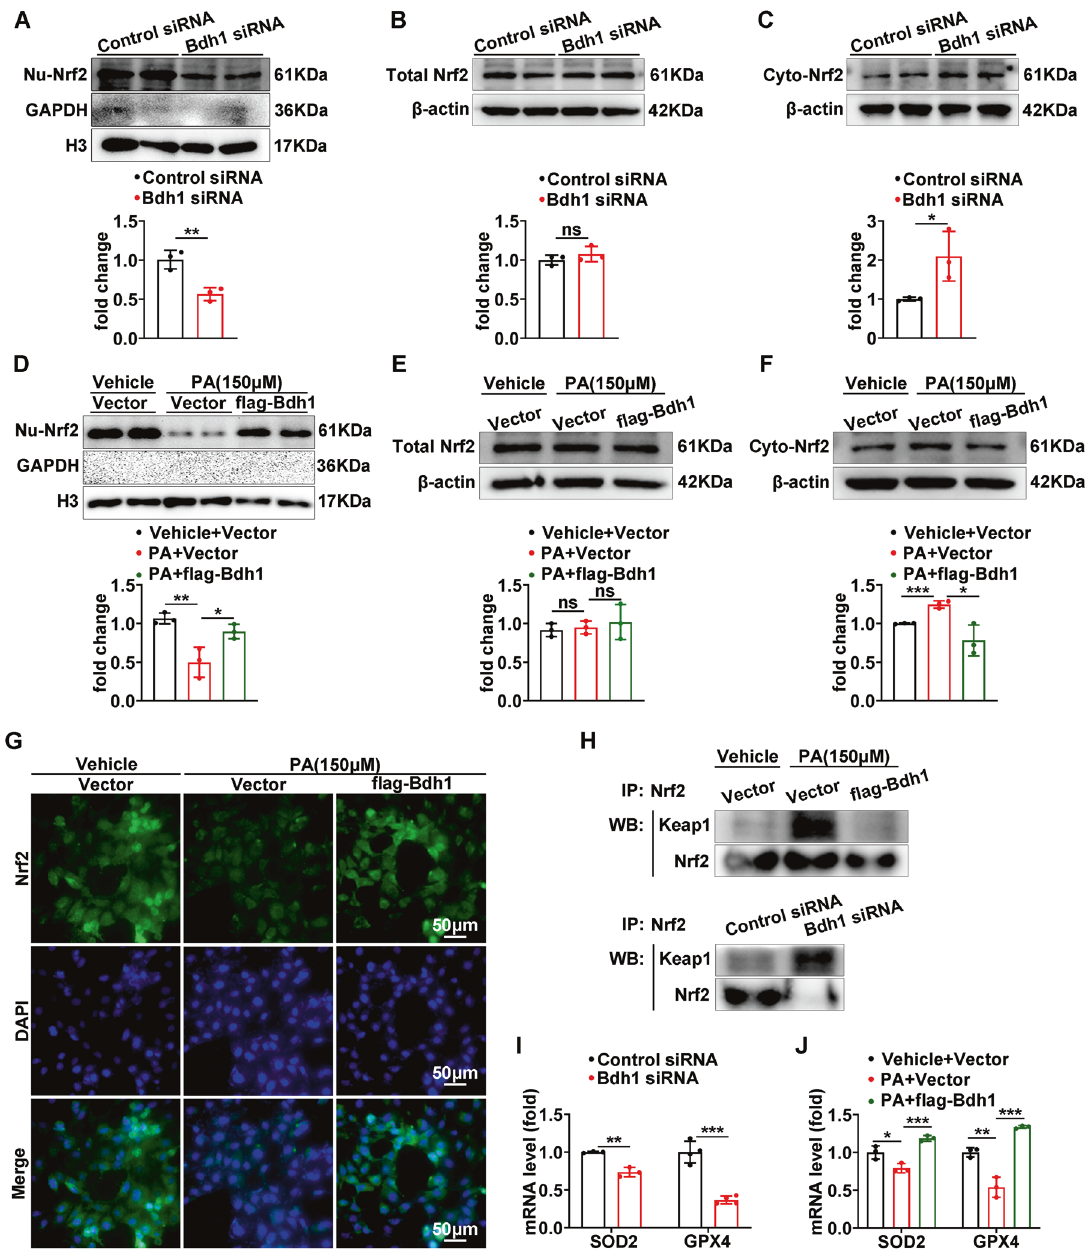
Fig. 4 Bdh1 promotes Nrf2 nuclear translocation and Nrf2-mediated antioxidant pathway. A – C Representative western blots showing the protein level of Nrf2 protein in the nuclear extracts ( A ), cytosolic extracts ( B ), and total lysates ( C ) of LO2 cells transfected with control siRNA or Bdh1 siRNA. D – F Representative western blots showing the protein level of Nrf2 in the nuclear extracts ( D ), cytosolic extracts ( E ), and total lysates ( F ) of vetor and Bdh1-overexpressed LO2 cells treated by vehicle or PA. G Representative IF images showing the location of Nrf2 in vetor and Bdh1-overexpressed LO2 cells treated by PA. Bar: 50 μ m. H Immunocoprecipitation showing the interaction between Keap1 and Nrf2 in LO2 cells with indicated treatment. I mRNA levels of GPX4 and SOD2 in LO2 cells transfected with control or Bdh1 siRNA. J mRNA levels of GPX4 and SOD2 in LO2 cells transfected with indicated treatment. LO2 cells were transfected with the plasmids overexpressing fl ag-Bdh1 or vector for 24 h, and then treated with vehicle or PA for 24 h. Bar: 50 μ m. All results are representative of three independent experiments. Values are presented as mean ± SD. * P < 0.05; ** P < 0.01; *** P < 0.001. Bdh1 activated Nrf2 by enhancing metabolic fl ux of fumarate Fig. 5B, Nrf2 knockdown blocked the anti-in fl ammation effect of production Bdh1 overexpression on PA-treated LO2 cells. Similarly, Nrf2 In Bdh1-mediated β OHB metabolism pathway, Bdh1 fi rstly knockdown also blocked the anti-ROS effect of Bdh1 over- metabolites β OHB into AcAc, which could enter into TCA cycle expression on PA-treated LO2 cells (Fig. 5C). Further TUNEL assay and then is metabolized into Succinate and fumarate in turn. As showed that LO2 cells transfected with fl ag-Bdh1 and Nrf2 siRNA the fumarate is a well-known activator of Nrf2 signaling, we next exhibited much more apoptosis than that transfected with fl ag- investigated whether Bdh1 activated Nrf2 by increase of fumarate. Bdh1 and Control siRNA (Fig. 5D). These data indicate that Bdh1 As expected, we found that the concentrations of AcAc, succinate, mediated anti-lipotoxicity function through activation of Nrf2.